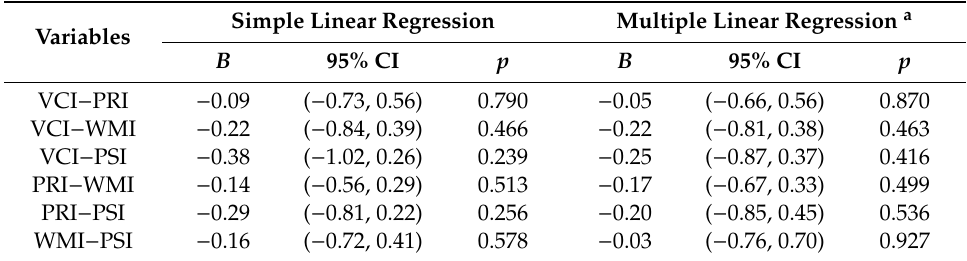
Table 6. The regression analysis between subtest-level discrepancy and angle of deviation in the exotropia group.